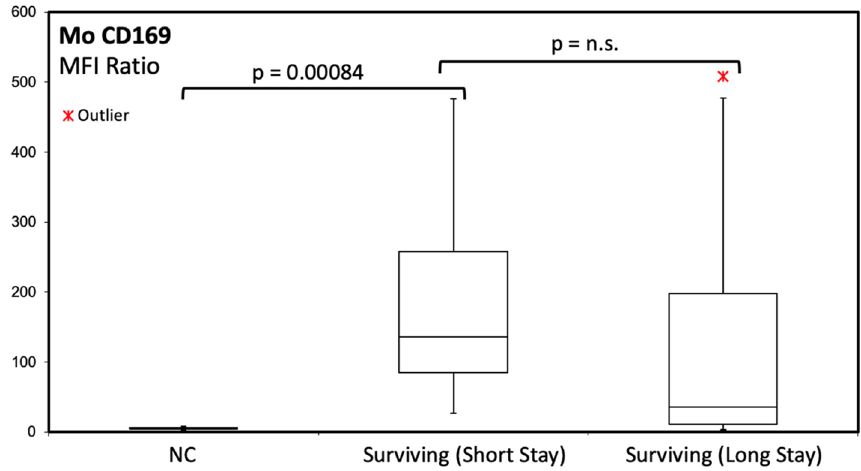
Fig. 1 Expression of monocyte CD169 in acutely SARS-CoV2-infected patients in the early phase of the disease and during the follow-up, according to the length of hospital stay. The overall trend to moCD169 downregulation in the long-term did not reach statistical significance, due to some patients with persistent positive swabs for